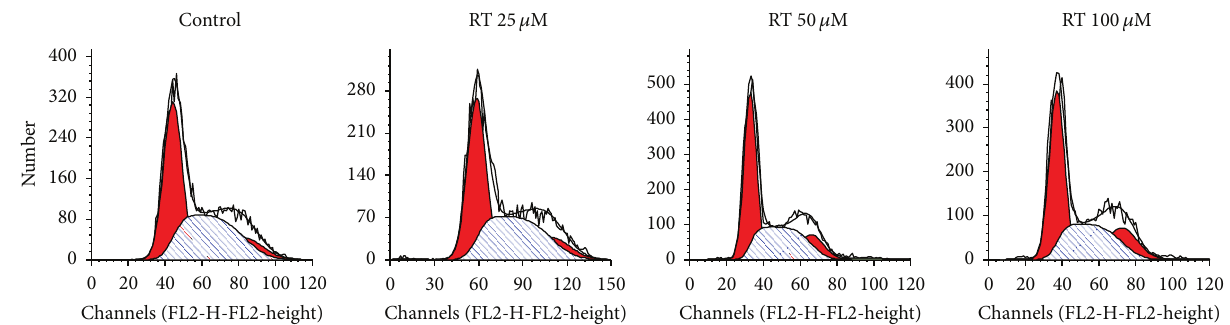
Figure 3: The effect of rutin on cell cycle. Cells were treated with rutin for 24h with designated rutin then washed with PBS to remove complete medium, and fixed with 75% per-cold alcohol then stained with PI, and the DNA content was analyzed by flow cytometry.